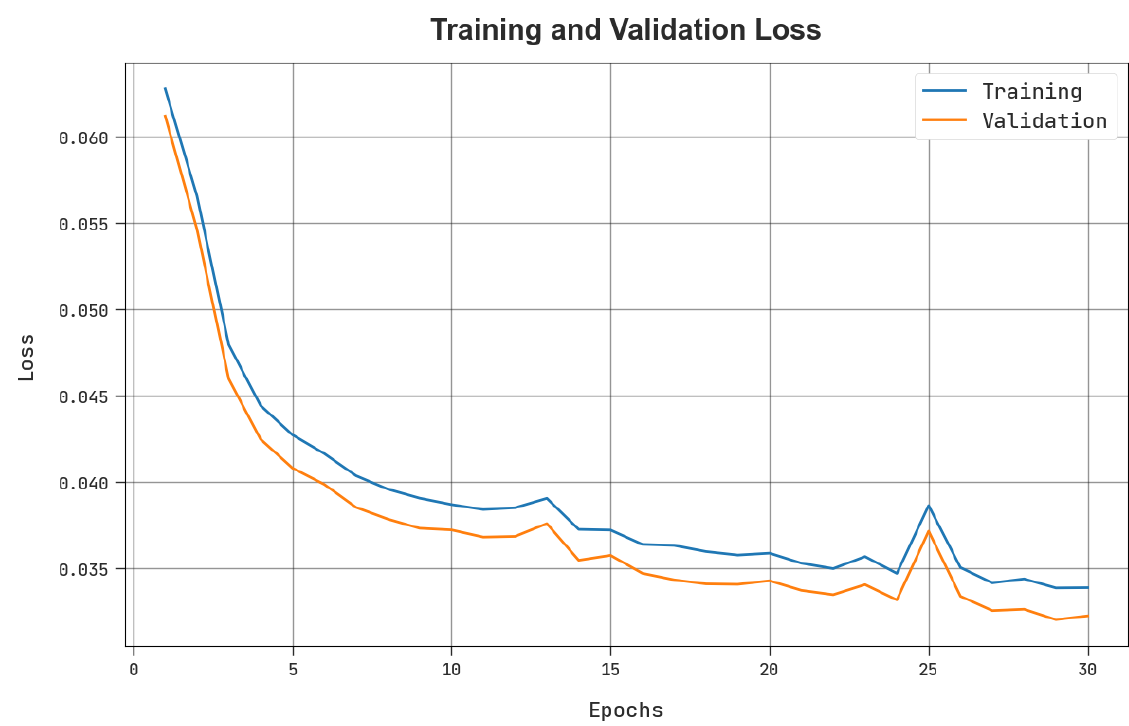
Figure 7. TLOS and VLOS outcome of the BCOA-MLID approach.